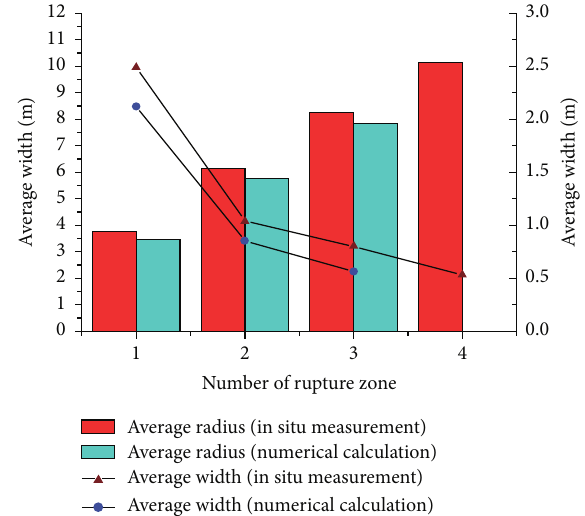
Figure 16: Width and quantity comparison in surrounding rock of